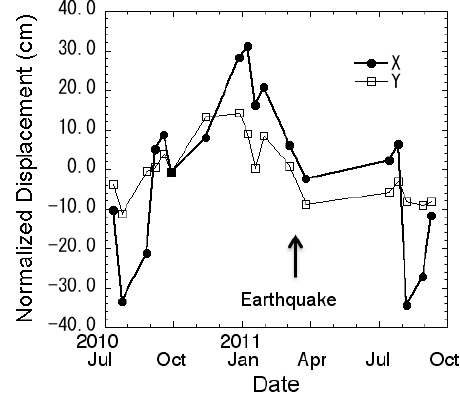
Table 3. Statistics of the spatial deviation of the displacement calculated from the each sub-area of the all pair of images